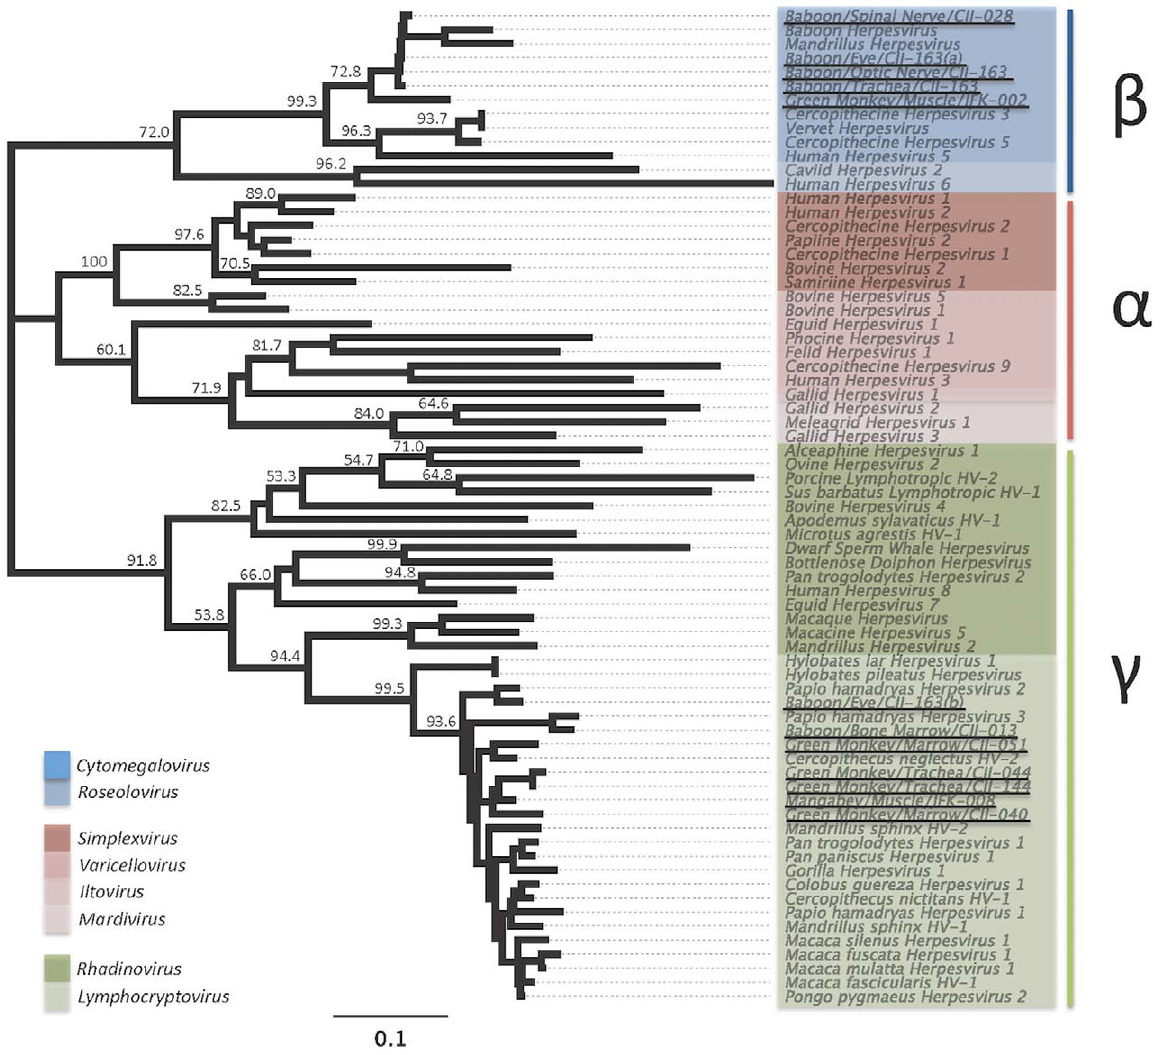
Figure 4. Inferred phylogenetic relationships of herpesviruses detected in siman bushmeat samples. Neighbor-joining (NJ) and maximum-likelihood (ML) analysis gave identical branching orders. Sequences identified in bushmeat products are underlined and cluster with sub- families betaherpesvirus (samples: CII-028, CII-163, BM-002), and gammaherpesvirus (samples: CII-163, CII-013, CII-051, CII-044, CII-144, CII-040, BM-008).